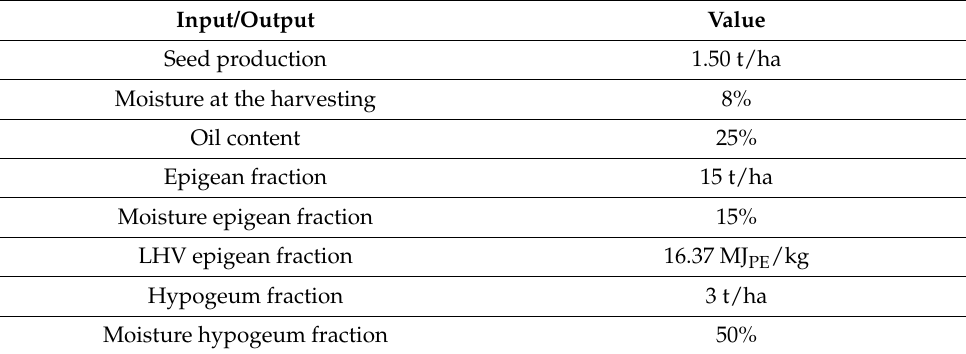
Table 2. Cardoon